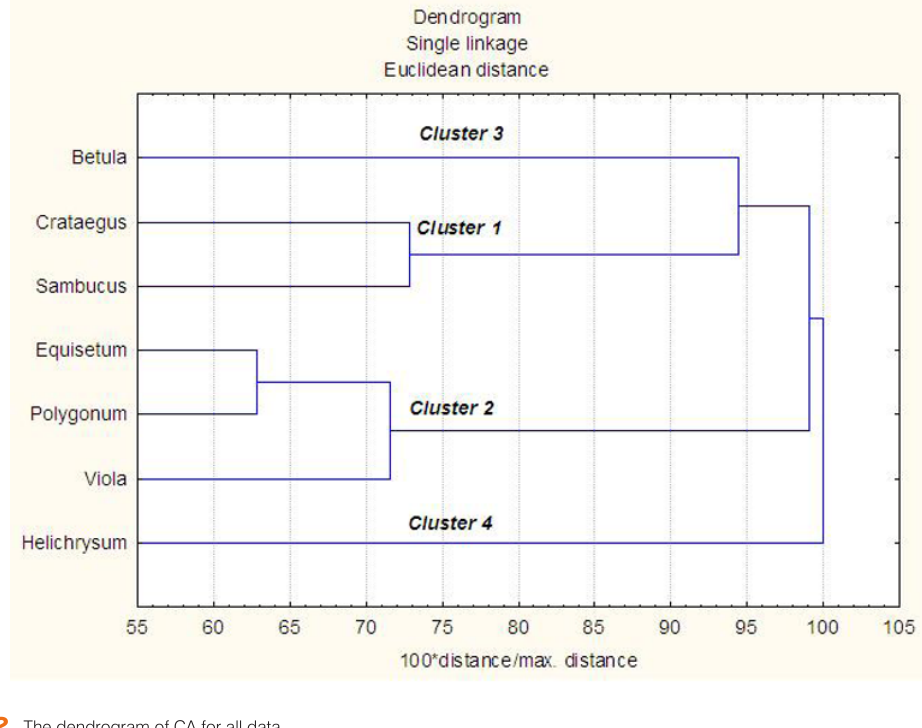
Figure 2. The dendrogram of CA for all data.